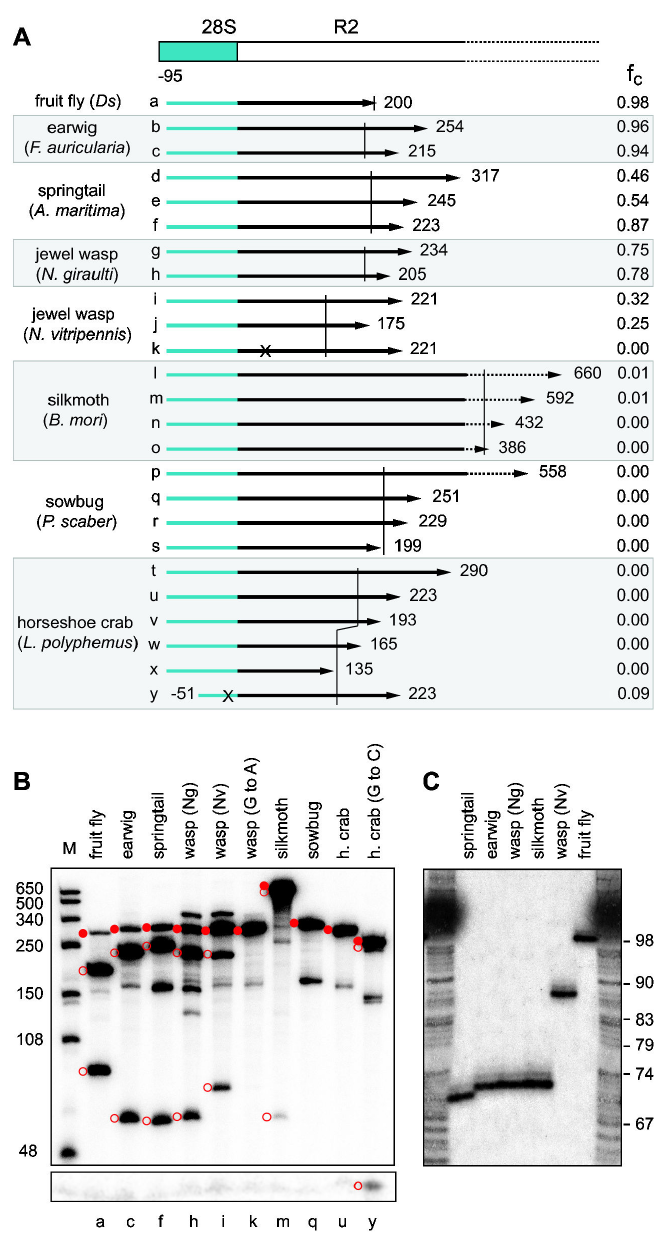
Figure 2. RNA comprising the 28S/R2 5' junction from many arthropods can function as a self-cleaving ribozyme. (A) Diagram of a generic 28S gene (blue box)/ R2 5' end (white box) junction. Arrows labeled a through y represent the in vitro generated RNAs tested for self-cleavage from the eight species listed on the left. Ds , D. simulans . RNAs (except y ) begin at position -95 relative to the R2 insertion site and end at the noted nucleotide within the R2 element. RNA k has a 'G' to 'A' change in the active site of the ribozyme; RNA y has a generated 'G' to 'C' change to improve the P1 stem (see text). The short vertical lines demarcate the extent of the predicted ribozymes. To the far right of each arrow is the average fraction of RNA cleaved in at least two independent co-transcription/cleavage assays. (B) A 5% denaturing acrylamide gel showing the cleavage products for select RNAs in the co-transcription/self-cleavage assays. A longer exposure of the lower portion of the gel is shown to better visualize the short upstream cleavage product. The uncleaved RNA (solid red circles) and cleavage products (open red circles) are indicated. Unmarked bands are alternative, stable RNA structures. Lanes are labeled with the corresponding letter from panel (A). Lane M, RNA length markers with sizes indicated. (C) An 8% denaturing acrylamide gel showing the upstream cleavage products at single nucleotide resolution. RNAs are the same as in (B) except RNA from the silkmoth was from S. cynthia . DNA ladder corresponds to combined G, A, T sequencing reactions with nucleotide position from the -40 primer in the m13 vector shown to the right. doi: 10.1371/journal.pone.0066441.g002 PLOS ONE |